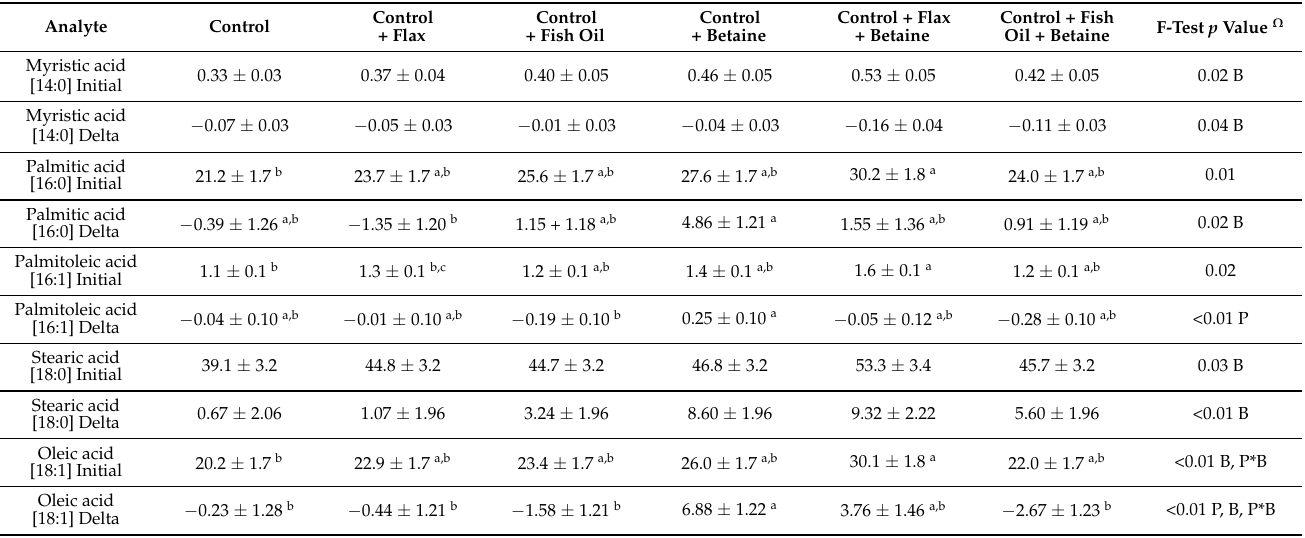
Table 4. Circulating concentration (mg/dL) of saturated and monounsaturated fatty acids profiles (values are lsmeans ± standard